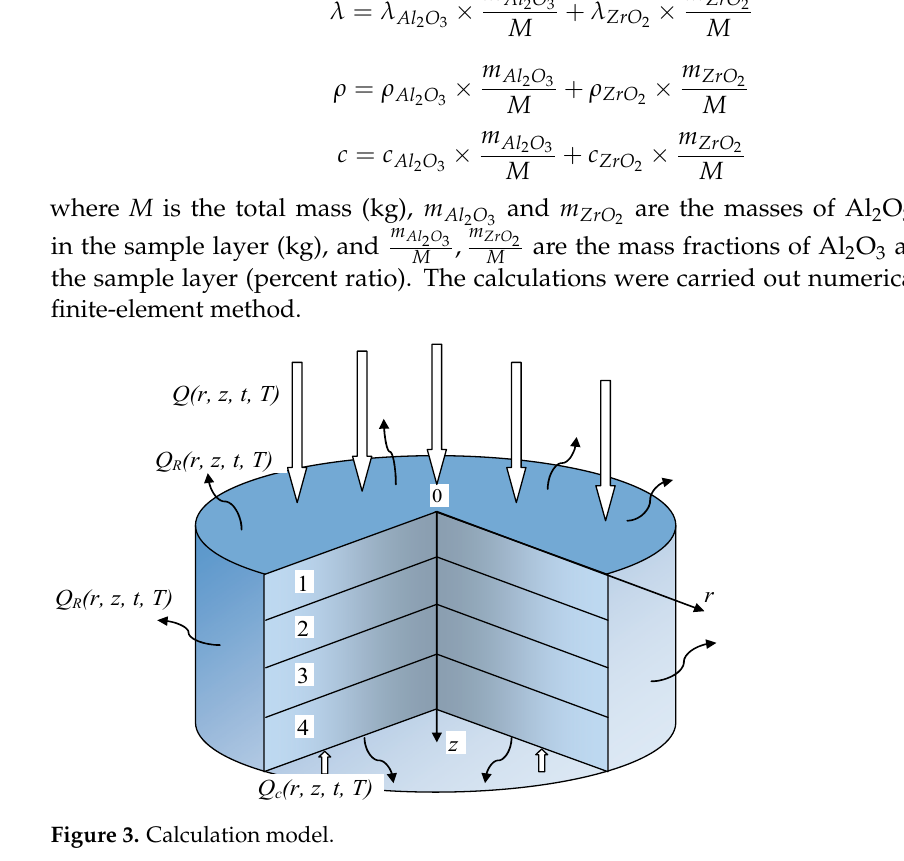
Table 1. Material parameters at ambient